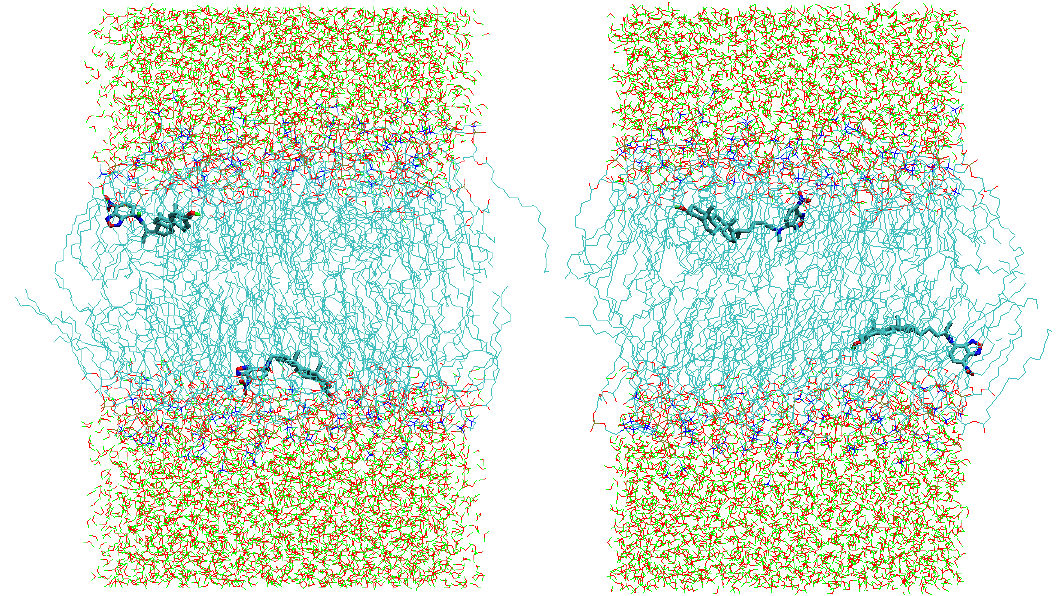
Figure 4. Final snapshots of 100-ns MD simulations of fully hydrated 128-molecule fluid POPC bilayers with either two 22-NBD-cholesterol (left) or two 25-NBD-cholesterol (right) molecules inserted. CH groups (n = 0–3), O atoms, N atoms and polar H atoms are n shown in cyan, red, blue and green,